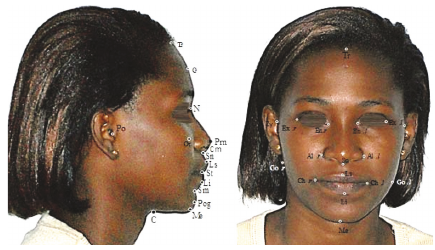
Figure 1: Landmarks used for profile